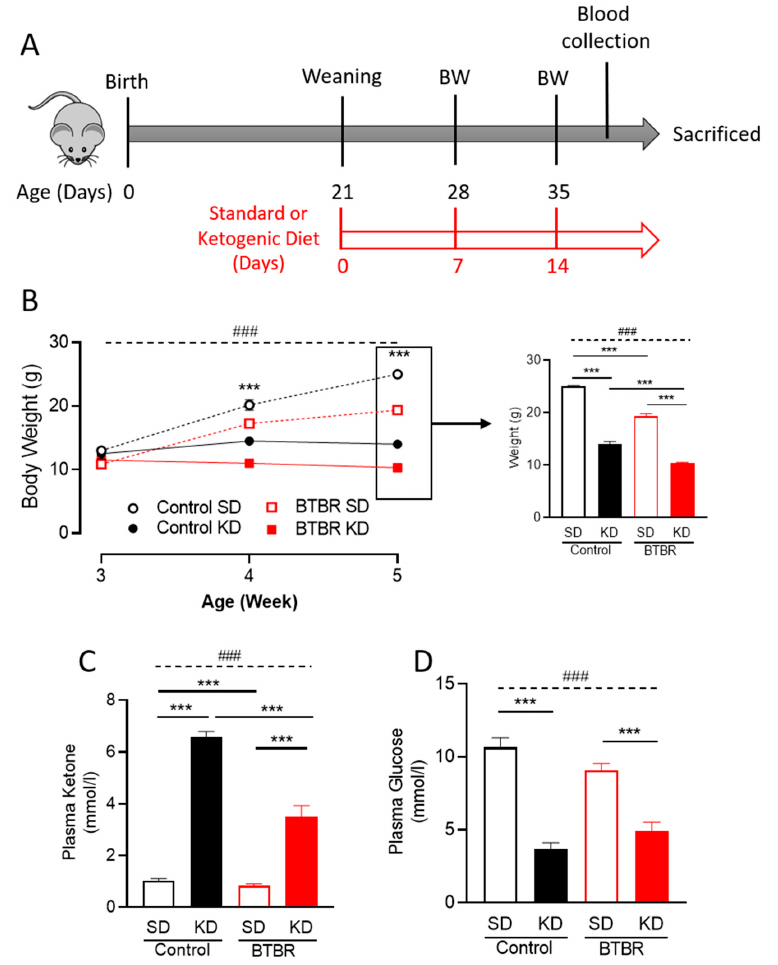
Figure 1. The ketogenic diet (KD) reduces body weight and induces ketosis in both control and BTBR mice. ( A ) Schematic drawing of the experimental protocol; after birth of control or BTBR mice, they were kept with their parents with a standard diet. After weaning at postnatal day 21 (PD21), the mice were placed on either a standard or a ketogenic diet. Body weight was measured after 7 and 14 days of diet (PD28 and PD35 weeks of age). Blood was collected to analyze for glucose and circulating ketone bodies. All mice were sacrificed at PD35 (after 2 weeks of diet intervention). ( B ) Average body weight trajectory of each group in response to the indicated diet (left panel). Data are shown as mean ± SEM, n = 4–8 per group. Data were analyzed by repeated two-way ANOVA. The significant e ff ects (main e ff ects from two-way ANOVA) are presented as: ### p < 0.001. Further, the significant di ff erences between groups in each timepoint revealed by the post-hoc analysis are presented as *** p < 0.001. To explore the body weight changes at PD35 (after two-week diet intervention), single timepoint body weight di ff erence data is presented (right panel). ( C ) Blood ketone and ( D ) glucose levels were measured in both control and BTBR mice sacrificed following the two-week diet intervention. Data are shown as mean ± SEM, n = 4–6 per group. Data were analyzed by two-way ANOVA. The significant e ff ects (main e ff ects from two-way ANOVA) are presented as ### p < 0.001. Further, the significant di ff erences between groups revealed by the post-hoc analysis are presented as *** p < 0.001. BW: body weight and SD: standard